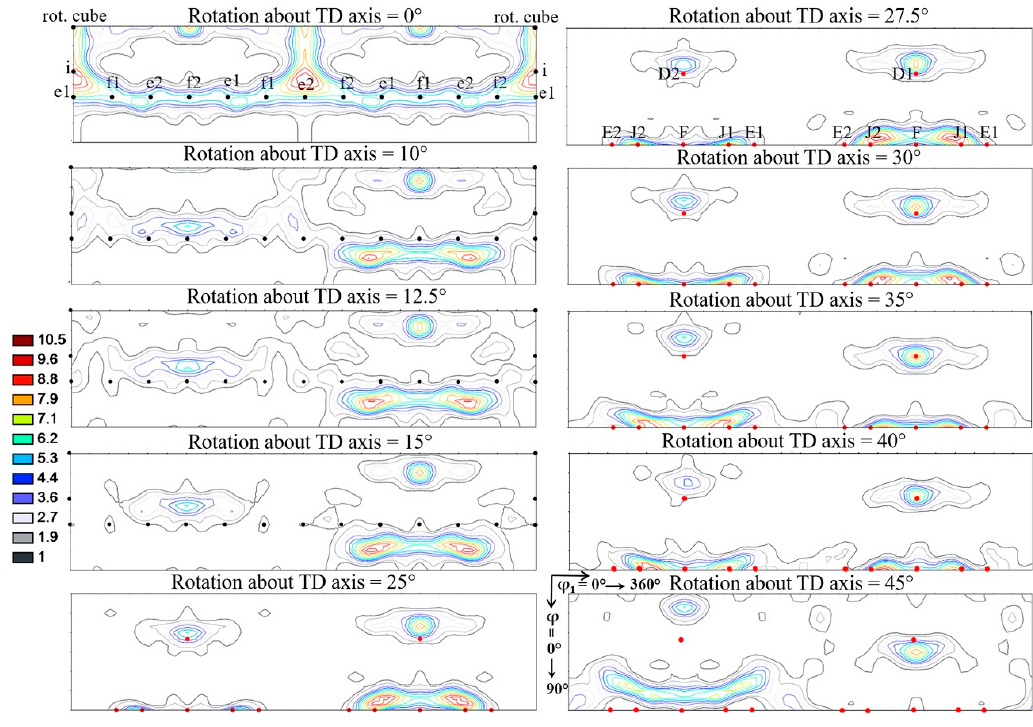
Figure 13. φ 2 = 45° sections of ODFs to represent the symmetric rolling texture migration towards Figure 13. ϕ 2 = 45 ◦ sections of ODFs to represent the symmetric rolling texture migration towards shear texture just by a simple rotation about the TD axis. shear texture just by a simple rotation about the TD